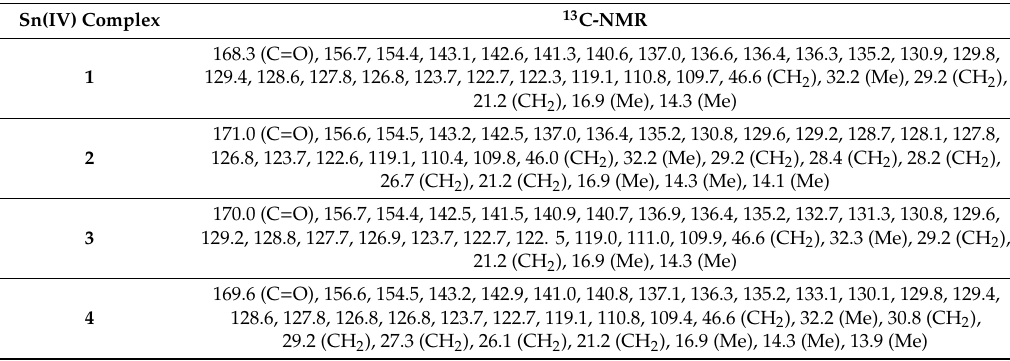
Table 4. 13 C-NMR Spectral data (ppm, DMSO- d 6 ) of complexes 1 – 4